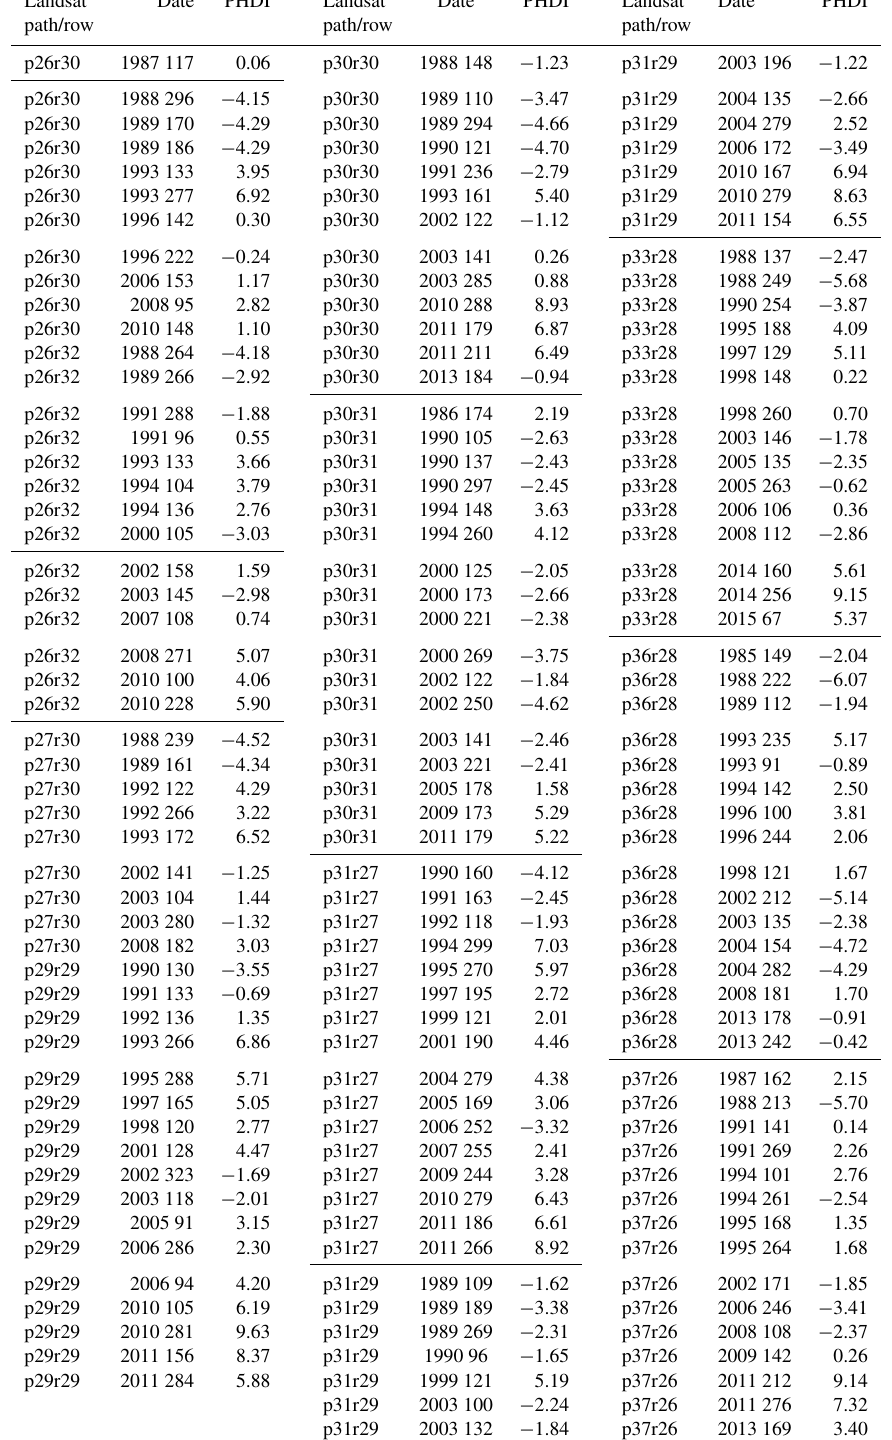
Table A1. A complete list of Landsat TM images used in the analysis and the corresponding Palmer Hydrological Drought Index